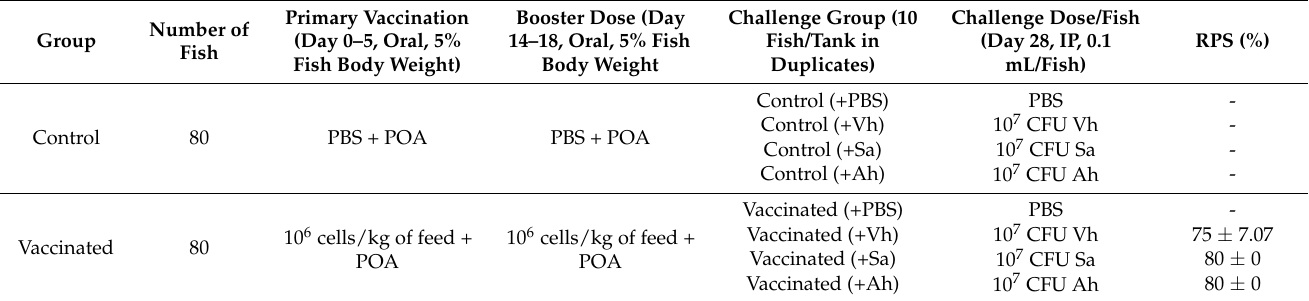
Table 6. Details of experimental design, vaccination scheme, challenge doses, and fish survival.